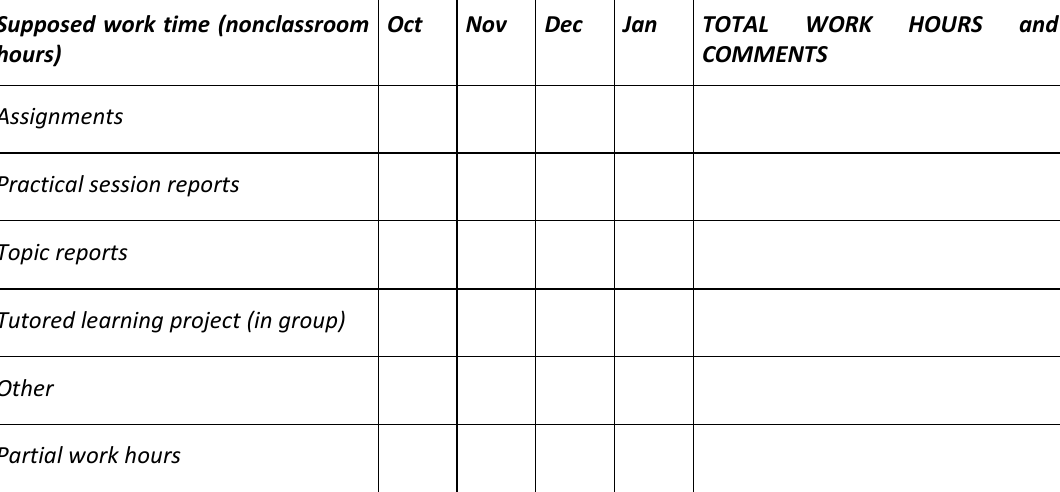
Table 8 – Table-summary of student work hours according to month and activities